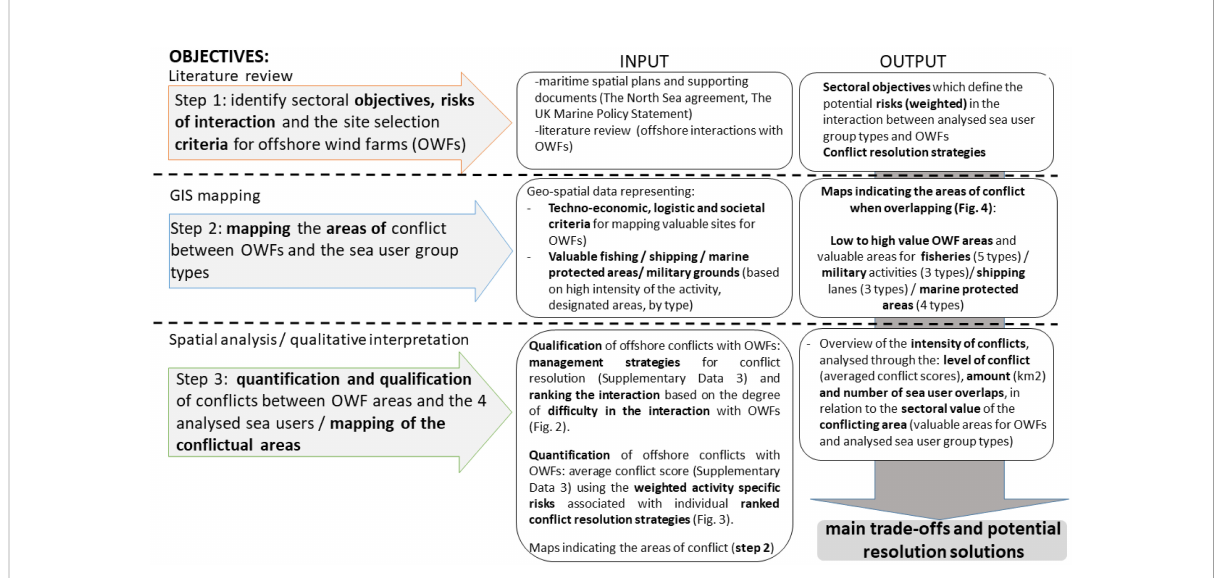
FIGURE 1 Sequence of steps for identifying trade-offs for the interactions of OWFs in the Dutch and English EEZ, with selected sea users: Fisheries (beam trawls, bottom otter trawl, bottom seine, pelagic trawls and seine, static gear), nature protected areas (seabed habitats, marine mammals habitats, birds habitats, fi sh habitats), shipping routes (cargo, passenger, tanker) and military activities ( fl ying areas, shooting areas, airspace radar